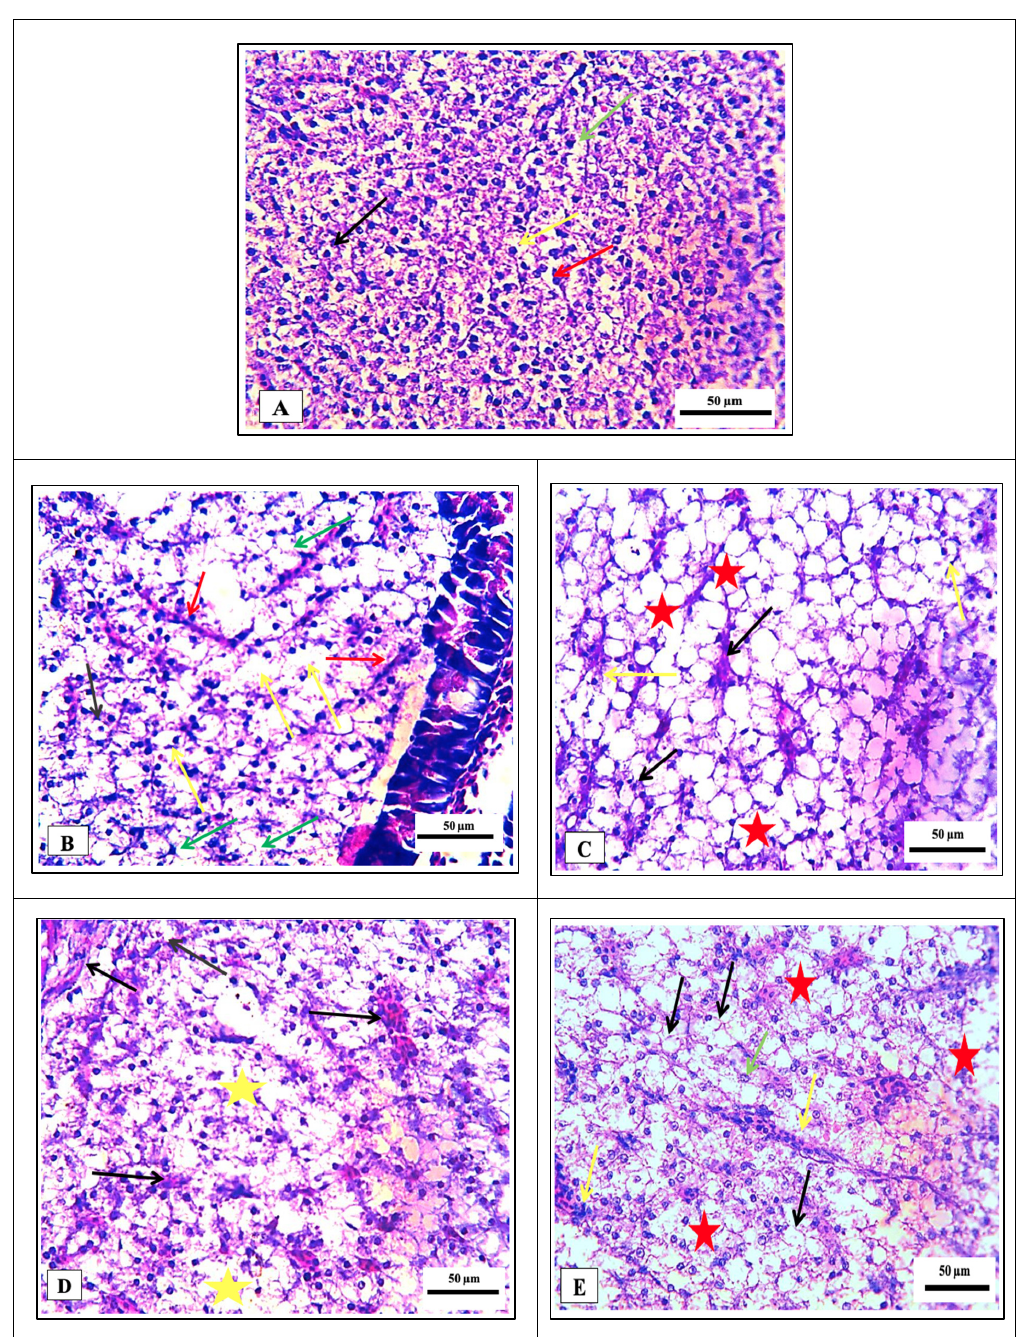
Figure 5. Photomicrographs of the liver of Nile tilapia, O. niloticus exposed to different concentrations of Hi -ZnO-NPs. ( A ) Unexposed (Control) liver showing hepatocyte (black arrow), spherical nucleus (yellow arrow), sinusoids (red arrow) and kupffer cells (green arrow). ( B ) Liver of Hi -ZnO-NPs (10 ppm)-treated O. niloticus showing cytoplasmic vacuolation (green arrow) necrosis (yellow arrow), pyknotic nuclei (brown arrow) and hemorrhage (red arrow). ( C ) 20 ppm treatment showing hepatocellular necrosis (yellow arrow), extreme cytoplasmic vacuolation (red star), and hemorrhage (black arrow). ( D ) 40 ppm treatment showing nuclei displaced to the cell periphery (red arrow), stasis within the sinusoid’s capillaries (black arrow) necrosis (yellow star). ( E ) 80 ppm treatment showing hepatocyte hypertrophy (green arrow) and stasis within the sinusoid’s capillaries infiltrated by inflammatory cells (yellow arrow) and cytoplasmic vacuolation (black arrow) with sever focal necrotic hepatocytes (red star). Stain H&E. Bar = 50 µ